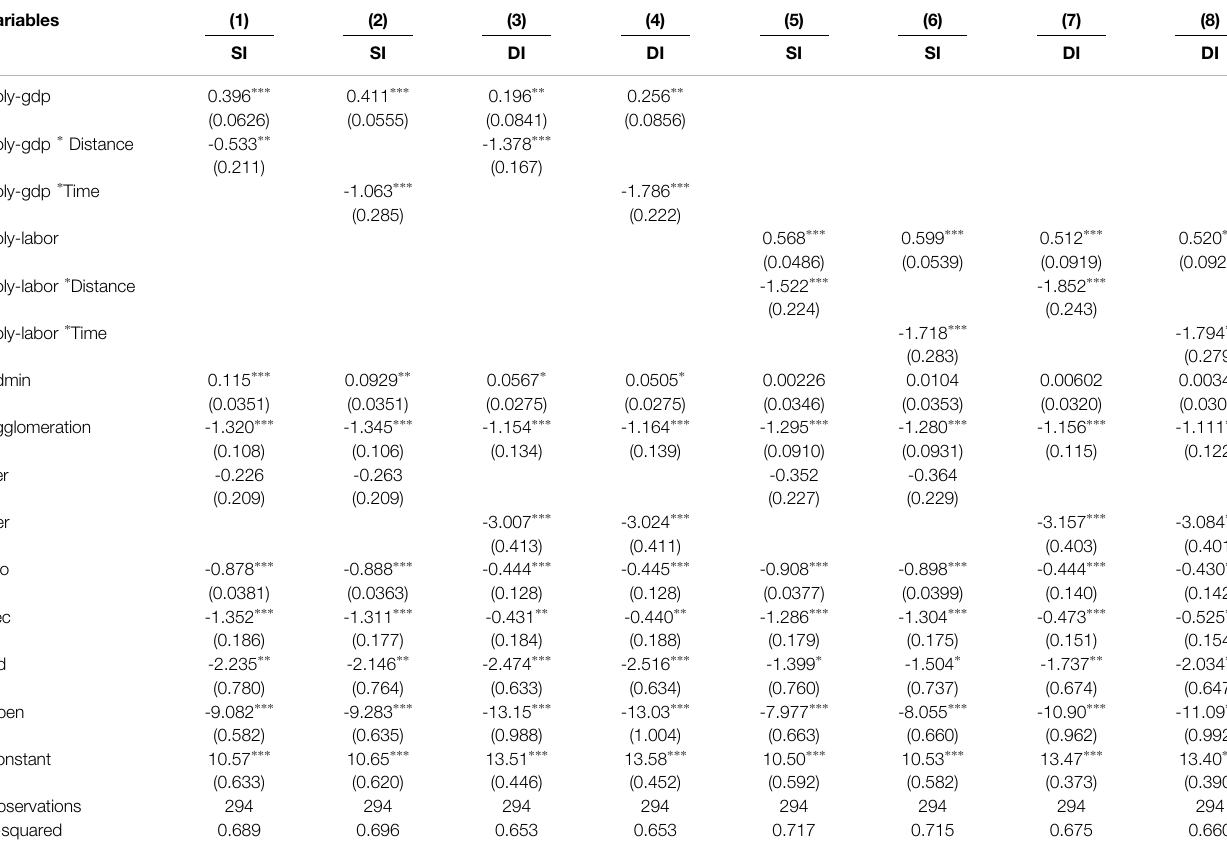
TABLE 6 | The interactive emission reduction effect of polycentricity, geographical compactness, and administration.